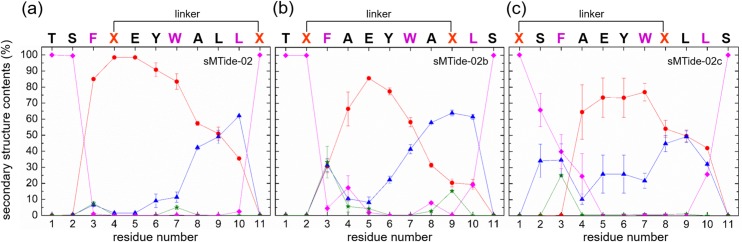
Average secondary structure contents of the free stapled p53 peptides.(a–c) Average secondary structure contents for the free sMTide-02 (a), sMTide-02b (b) and sMTide-02c (c) (red circles, helix; blue triangles, turn; green stars, bend, and magenta diamonds, coil).